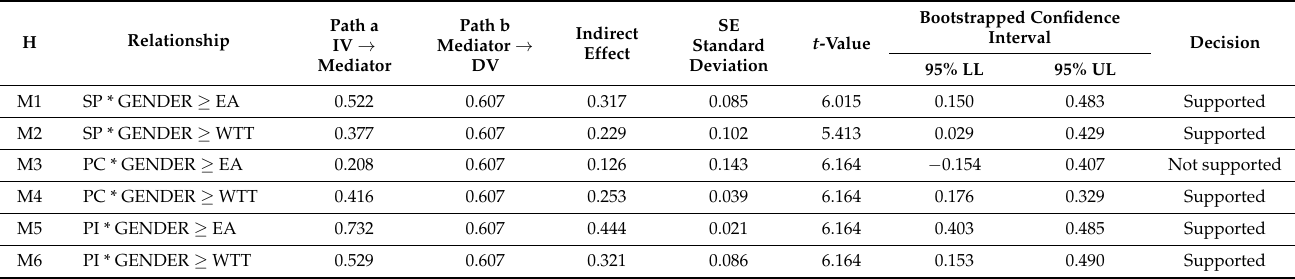
Table 8. Moderator Analysis